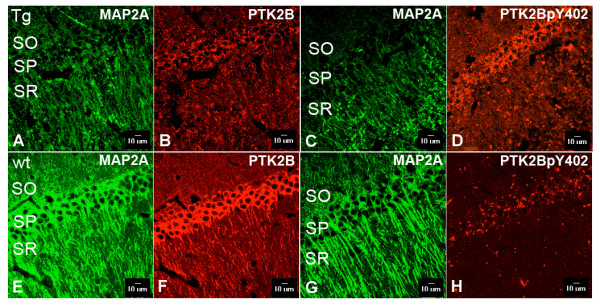
Up-regulation of PTK2B detected by immunolabelling in the hippocampal CA1 region of Glud1 Tg mouse brain. Antibodies against PTK2B, phosphorylated PTK2B (PTK2BpY402), and MAP2A were used to label reactive neurons in the hippocampal CA1 region of 11 mo Glud1 (A-D) and wt (E-H) mice. Immunolabelled sections were examined under confocal microscopy as described under Methods. Compared with hippocampus neurons in wt mouse, those in the Glud1 Tg mouse exhibited a substantial decrease in dendritic labelling by MAP2A (see also text). On the other hand, labelling by PTK2BpY402 in Tg mouse hippocampus appeared to be higher than that observed in wt mice. After normalization of PTK2BpY402 immunoreactivity by expressing it as a ratio of PTK2BpY402 to MAP2A labelling, the levels of PTK2BpY402 were significantly higher in the Glud1 Tg neurons (see also text), a possible sign of increase in neurite growth in neurons of Tg mice. SO, stratum oriens; SP, stratum pyramidale; SR, stratum radiatum. Scale bars: 10 μm.